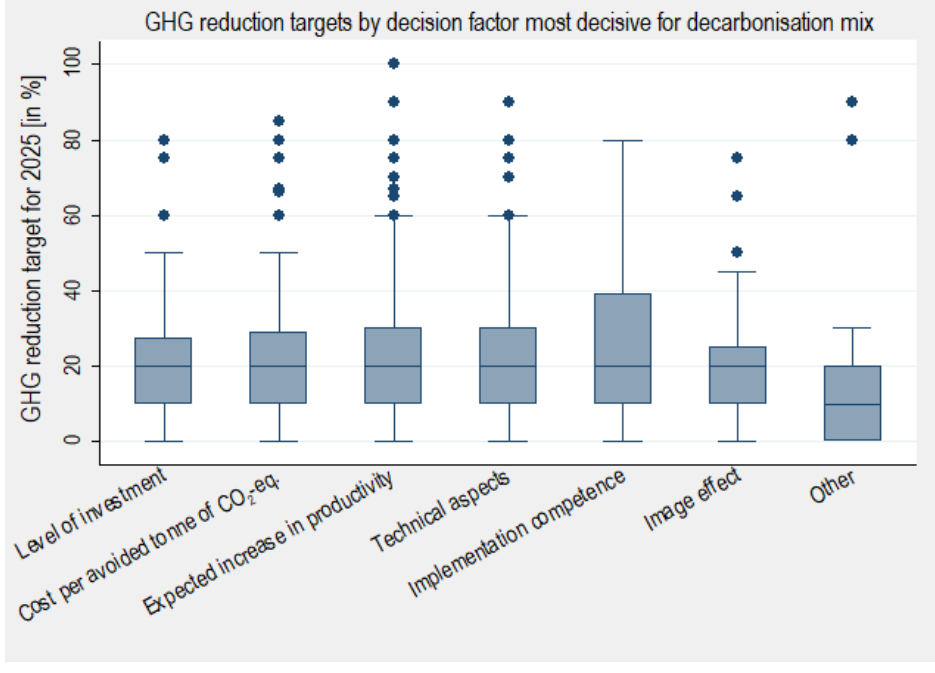
Figure 7. GHG reduction targets by decision factor most decisive for decarbonisation mix [40].